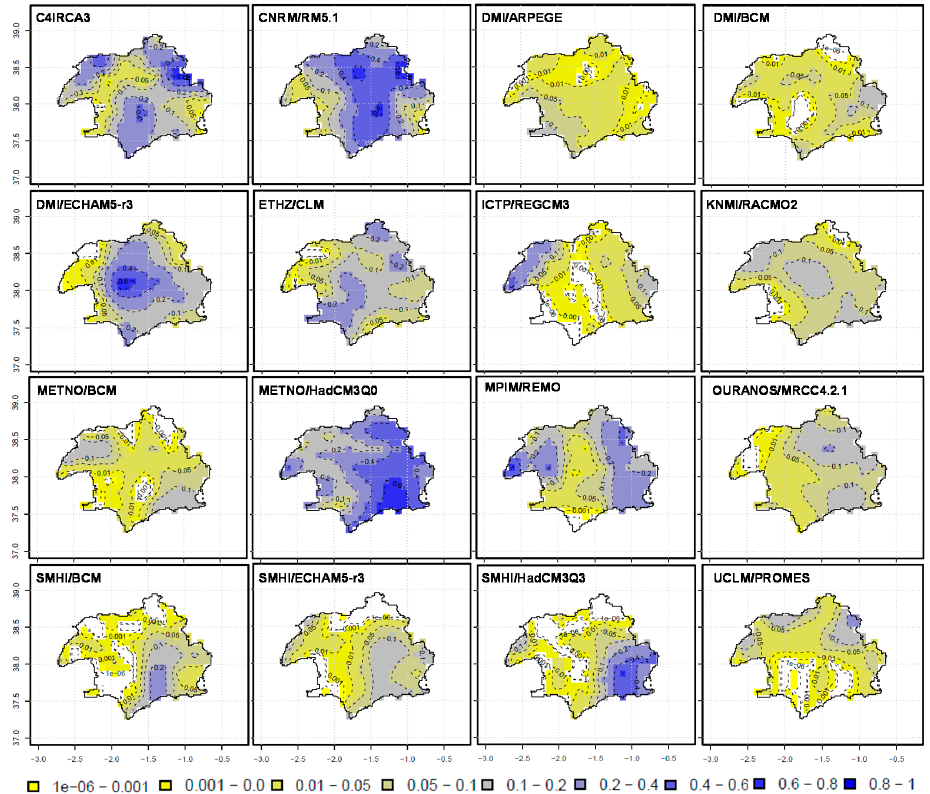
Figure 4. Spatial distribution of reliability factor ( R i ) values for rainfall, estimated with Equation (2).